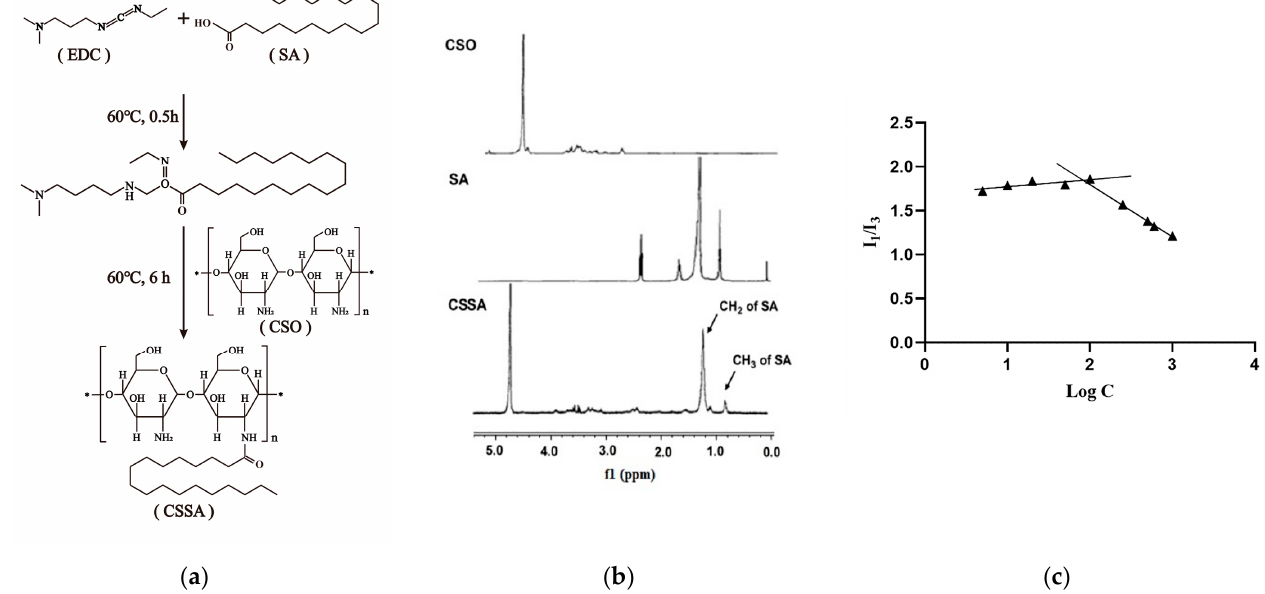
Figure 1. Synthesis and characterizations of CSSA. ( a ) Synthesis route of CSSA; ( b ) 1 H NMR spectra of CSO, SA and CSSA; ( c ) Variation of intensity ratio (I 1 /I 3 ) vs. concentration ( μ g/mL) of CSSA ( ▲ ).